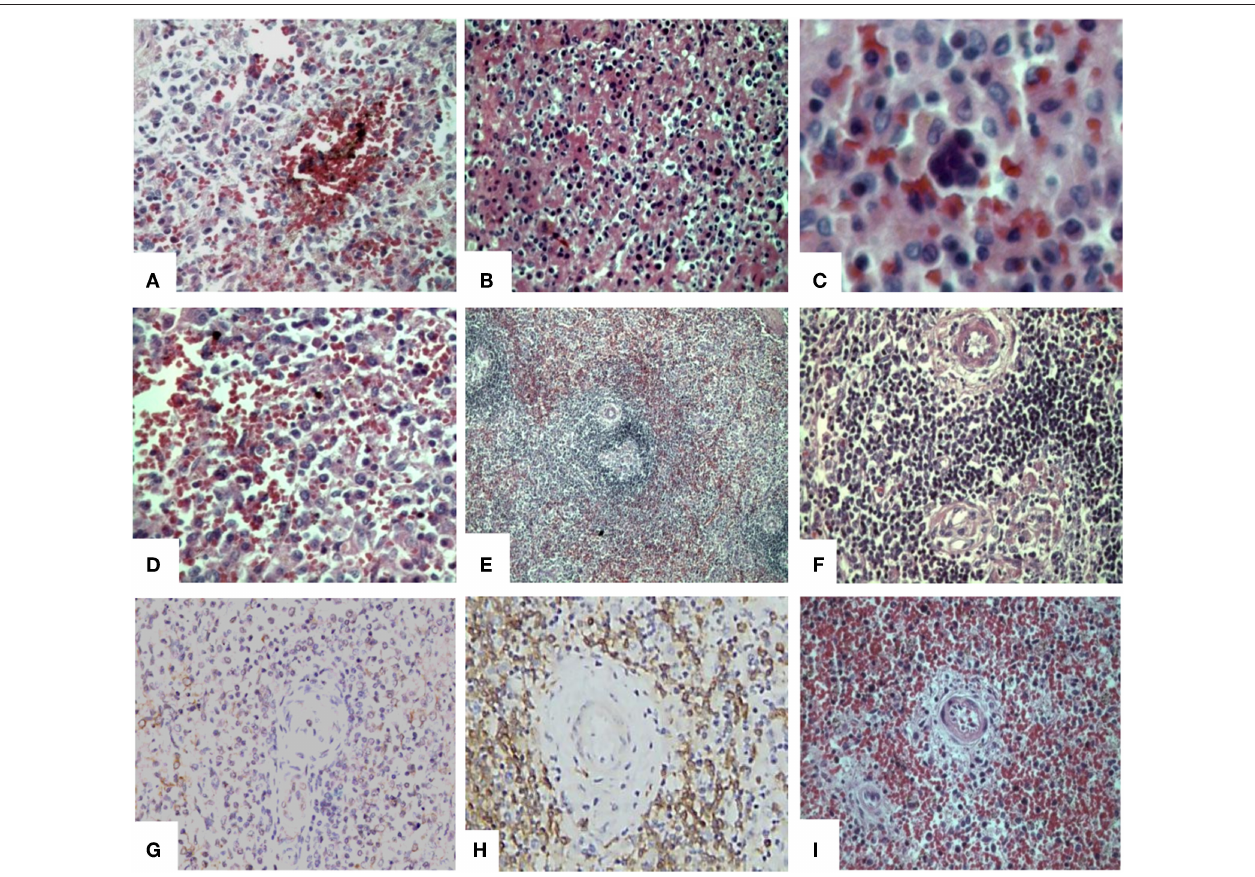
FIGURE 1 | Histological and immunohistochemical findings in the spleen of patients with severe leptospirosis with pulmonary hemorrhage and shock. Spleen from a patient with leptospirosis with (A) congestion, hemorrhage and haemosiderin pigments (HE); (B) acute splenitis with neutrophils, eosinophils, plasma cells, reticular cells, and macrophages (HE); (C) extramedullary haematopoiesis (HE) and (D) hypertrophic and hyperplasic reticular cells and macrophages increased in the red pulp (HE). Control patient with (E) adequate white pulp, with germinative center (HE); and (F) normal T-zone and B-zone (HE); (G) Spleen from a leptospirosis patient with positive IH for Leptospira antigens in the red pulp. Spleen from a bacterial septic patient with (H) white pulp with low TCD8 + density by IH stain and (I) red pulp congestion and atrophic follicles with depleted T-zone and B-zone(HE). Original magnification 400 × , except for (C) oil immersion (1000 × ) and (E) 200 × . HE, Haematoxylin-Eosin; IH,